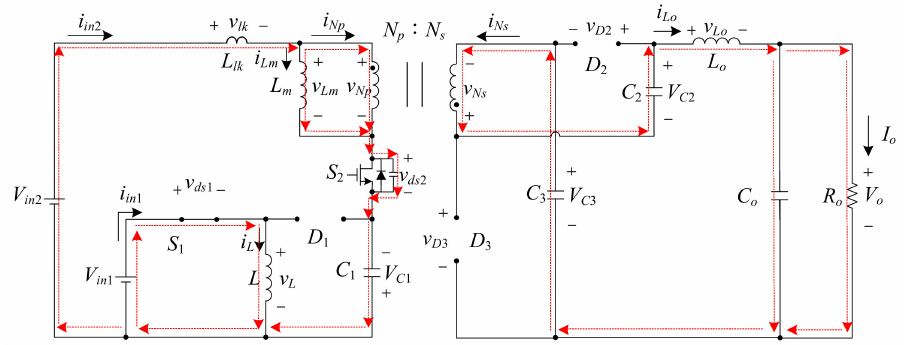
Figure 8. State 2 power